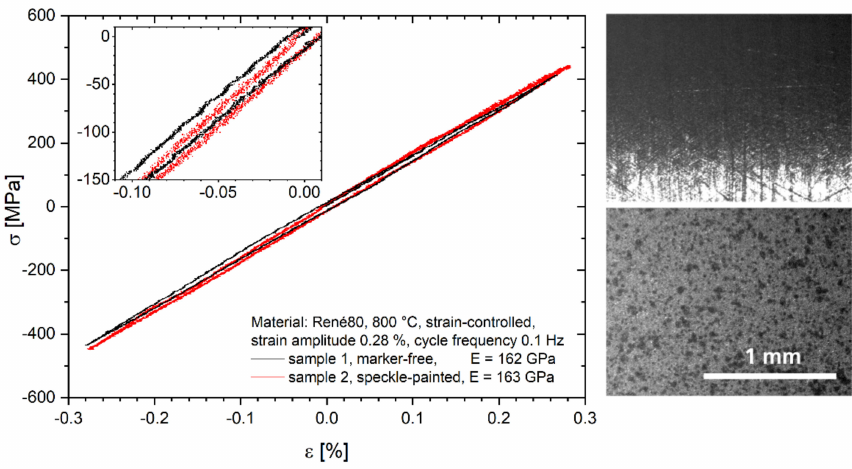
Figure 7. Left : Strain-controlled stress–strain diagrams of a marker-free and a speckle-painted Ren é 80 samples. The inset shows the noise of both measurements. Right : Camera images from the marker-free sample 1 ( top ) and the speckle-painted sample 2 ( bottom